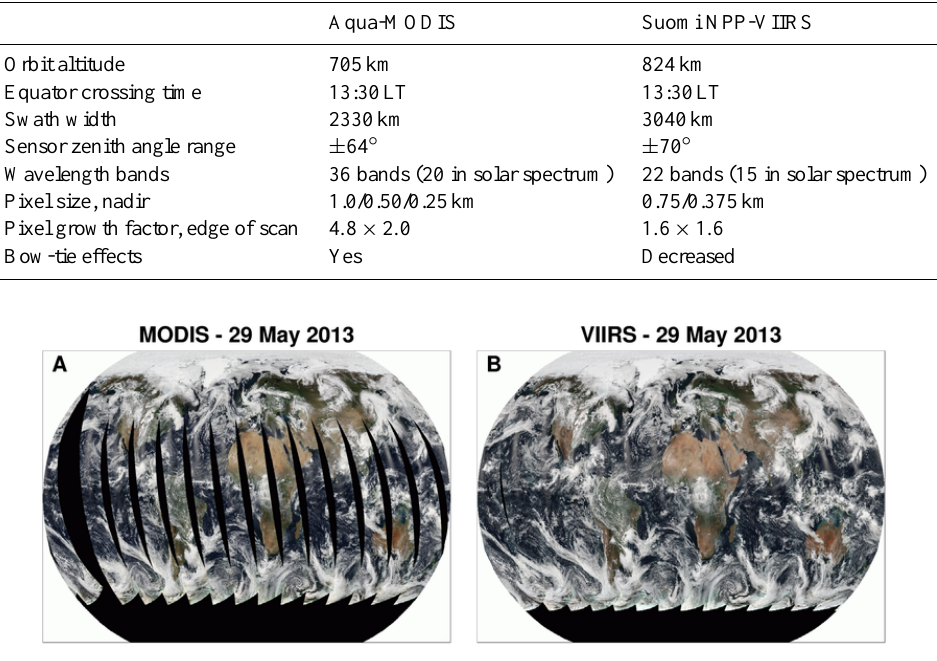
Figure 1. “True-color” RGB images for MODIS (a) and VIIRS (b) , created from all orbits during 29 May 2013. Note the increased VIIRS swath width, and full daily global